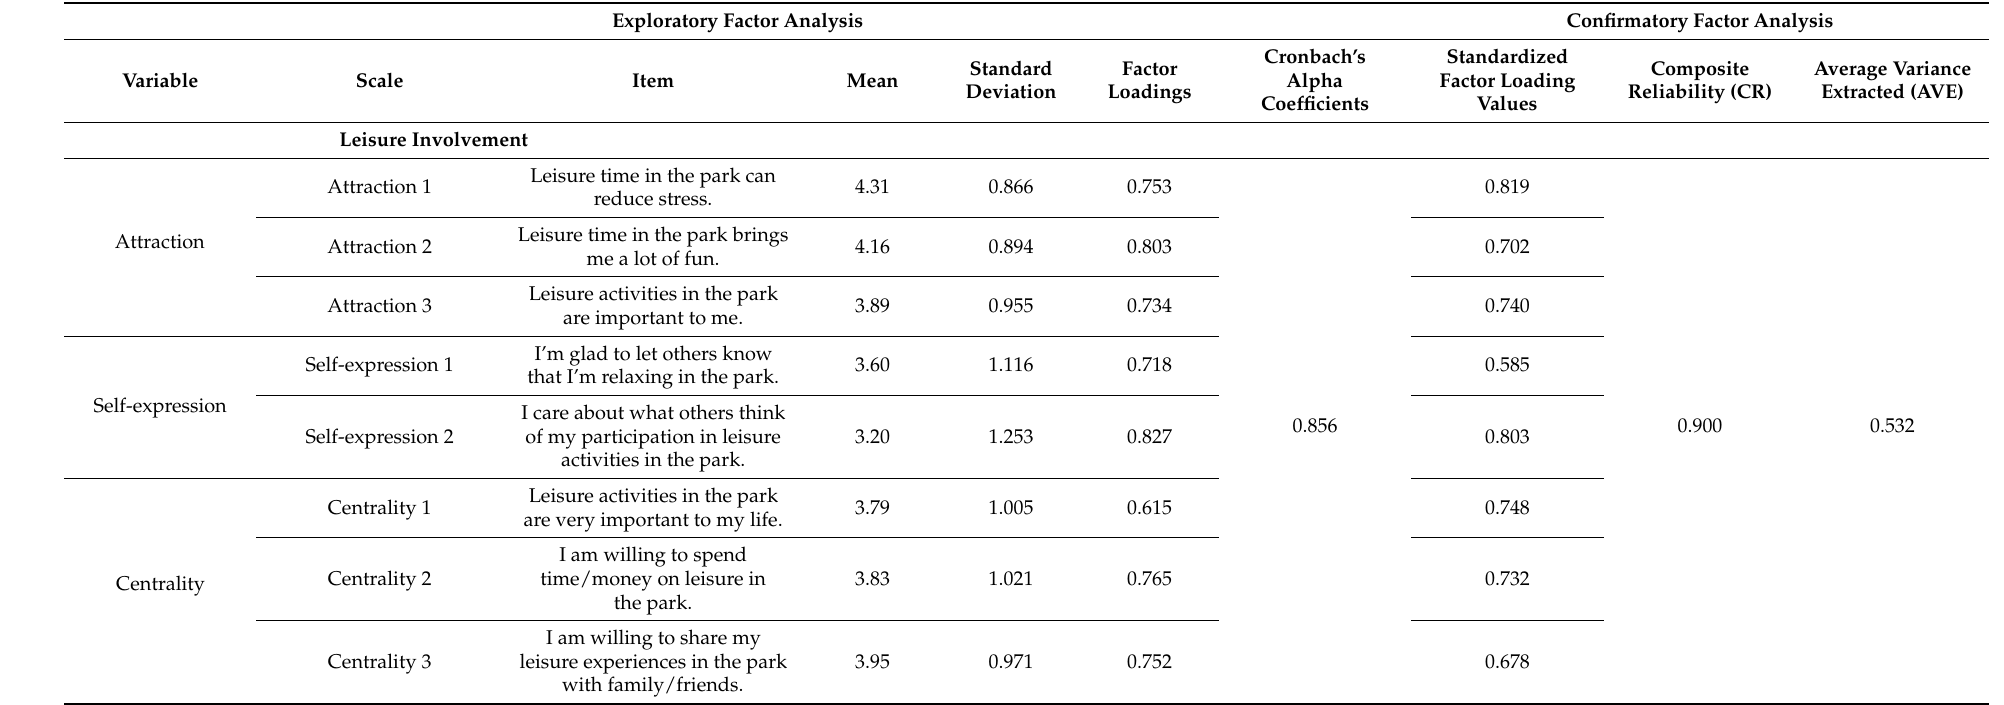
Table 3. Results of the reliability and validity